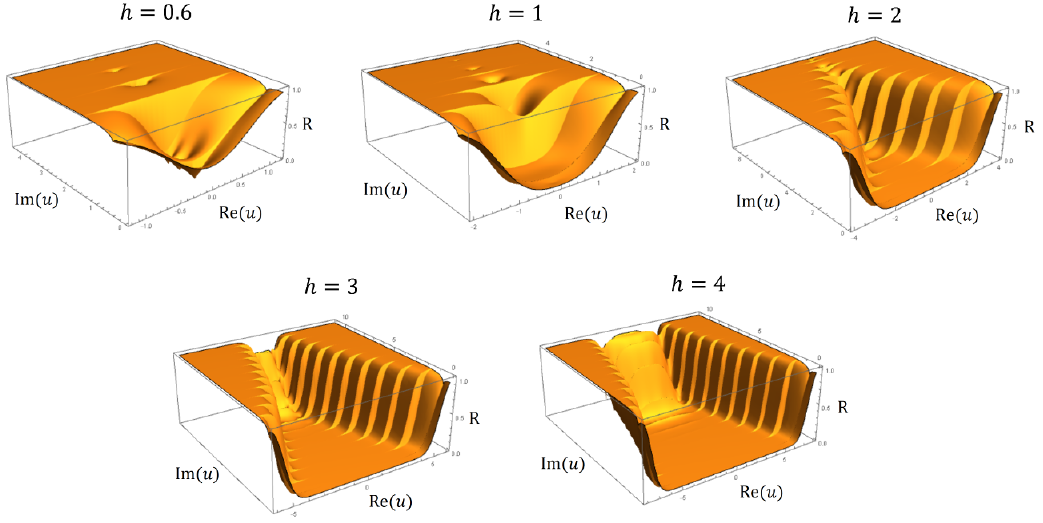
Figure 7 . Plots of the ratio R , de(cid:12)ned in (4.12), for di(cid:11)erent values of h . R tends to zero in the whole complex plane as h grows, thus hinting that Y 1 ; 0 tends to (cid:0) 1 at strong coupling, for the L = 1 ; S = 1